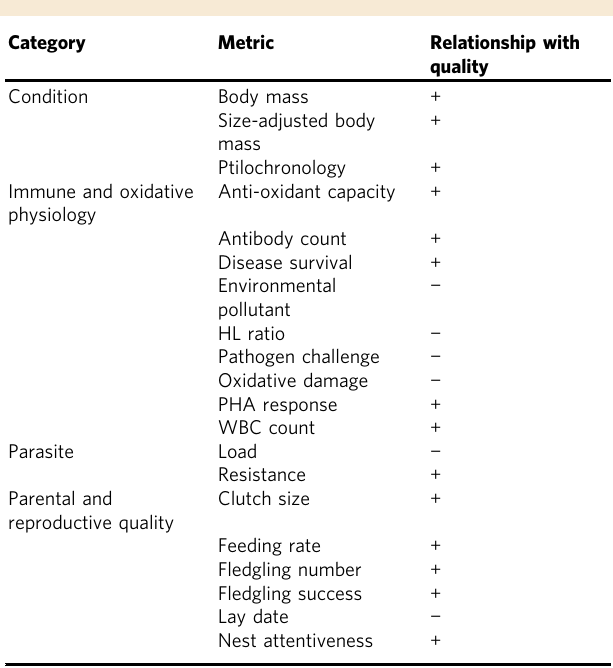
Table 2 Commonly used proxies for quality to evaluate the relationship between carotenoid-based feather